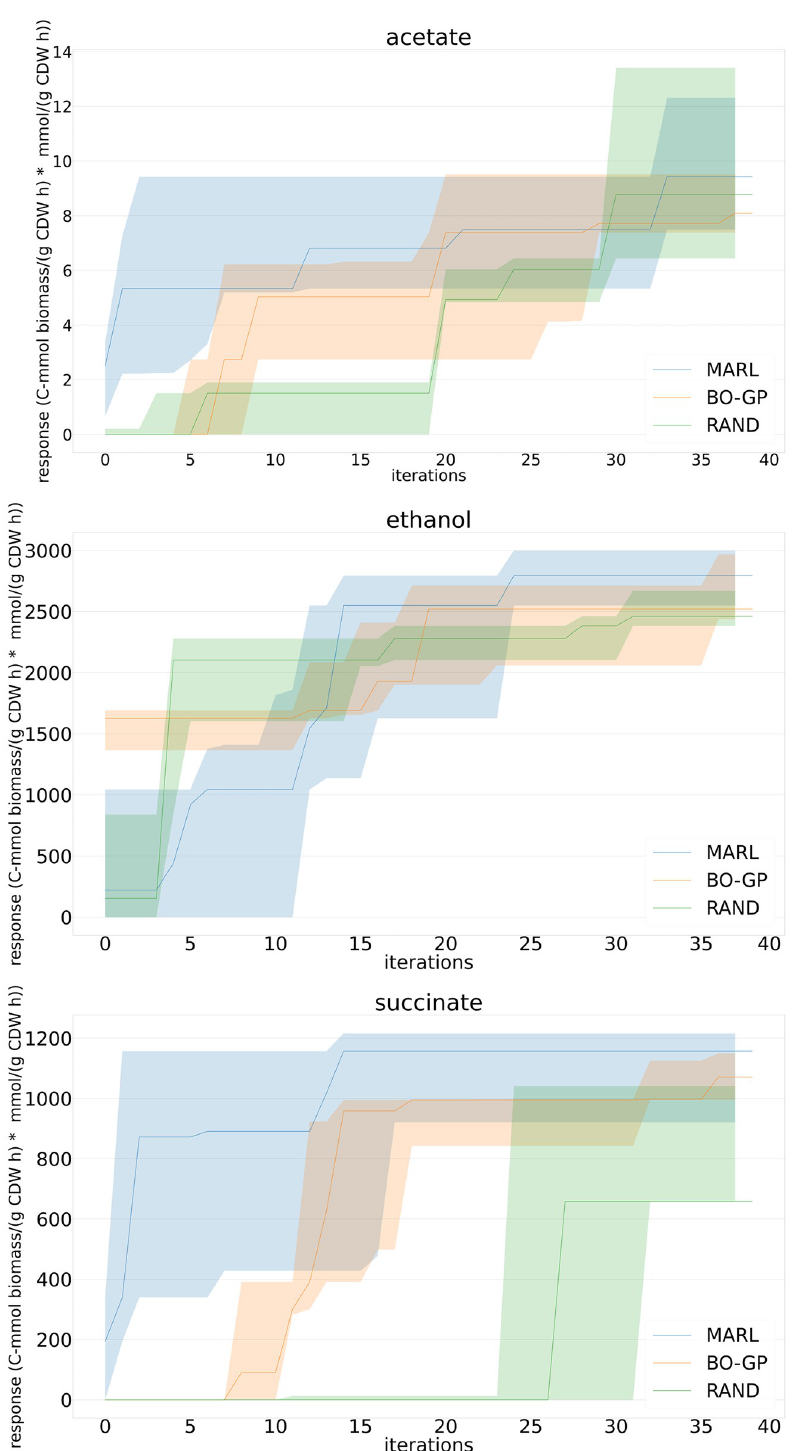
Fig 3. The development of the median (solid lines) and 25th to the 75th percentile (shaded areas) of the response (growth � production, C-mmol biomass/(g CDW h) � mmol/(g CDW h)) in k-ecoli457 model using MARL, BO-GP and RAND, in acetate (top), ethanol (middle) and succinic acid (bottom) production.